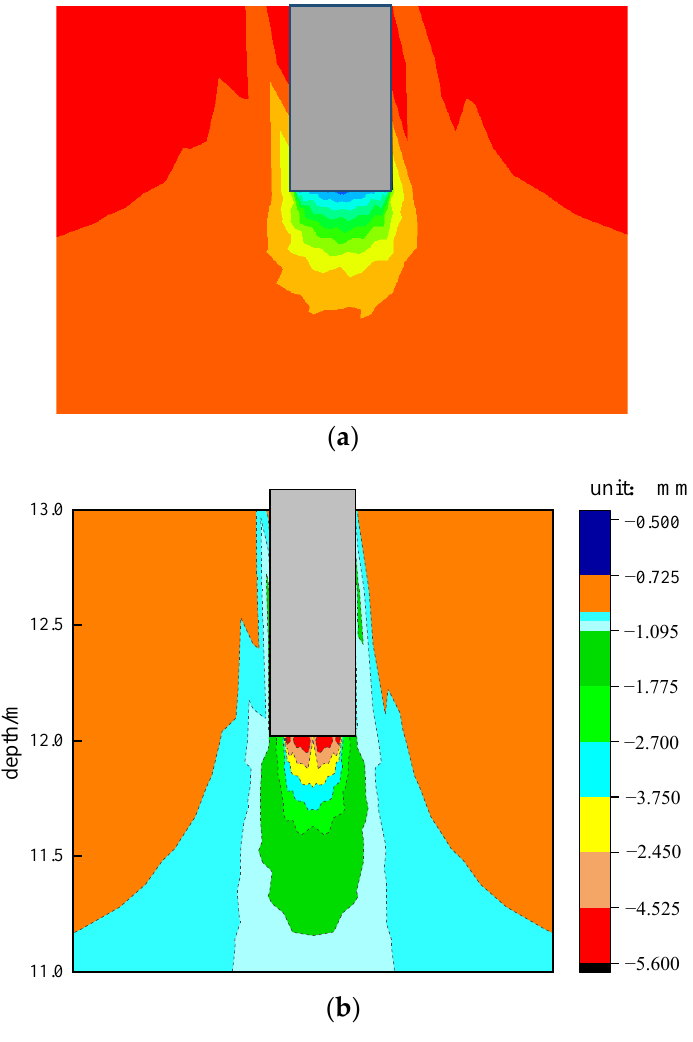
Figure 15. Vertical displacement nephogram of mudstone at the pile tip. ( a ) Vertical displacement cloud diagram of mudstone at pile end; ( b ) Optimized vertical displacement cloud diagram of mudstone at pile end.